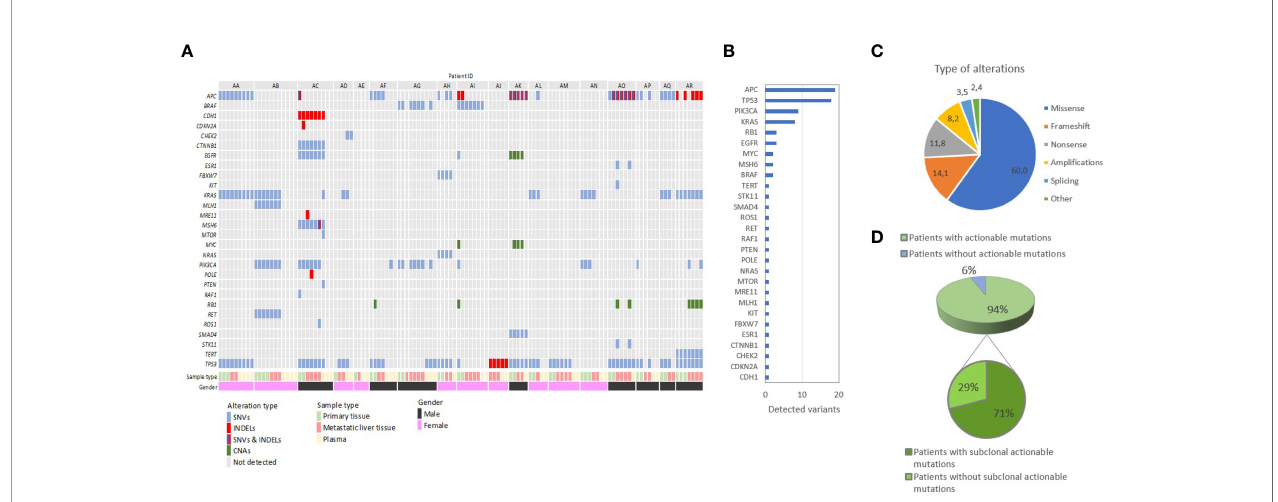
FIGURE 3 | Summary of the distribution of genetic alterations among all tissue and liquid biopsy samples from our cohort of 18 patients with metastatic colorectal adenocarcinoma. (A) Oncoplot shows the patients in a horizontal orientation and the gene and corresponding driver mutations in the vertical orientation. (B) Frequency of mutations observed per gene: The frequency of mutations is estimated based on the cumulative list of variants per patient. The number of variants identi fi ed in all patients is shown. (C) Distribution of different types of genetic alterations identi fi ed in the study. (D) Overall detection of potentially actionable mutations and their clonal status in our study: 71% of all patients with detectable actionable mutations harbored subclonal putative oncotargets, de fi ned as being present in some but not all tumor